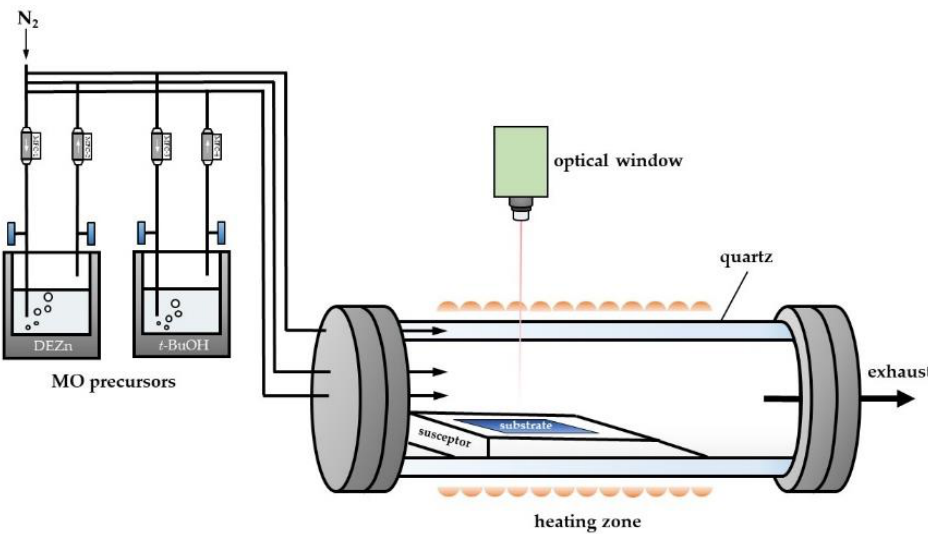
Figure 2. Schematic diagram of the MOCVD system for ZnO growth by using DEZn and t -BuOH as precursors.